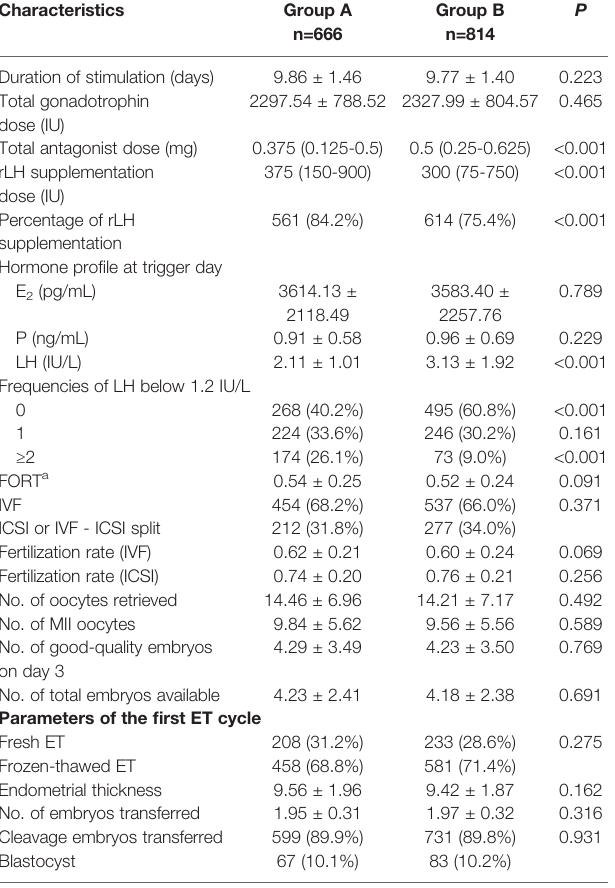
TABLE 2 | Parameters of ovarian stimulation and embryo transfer.